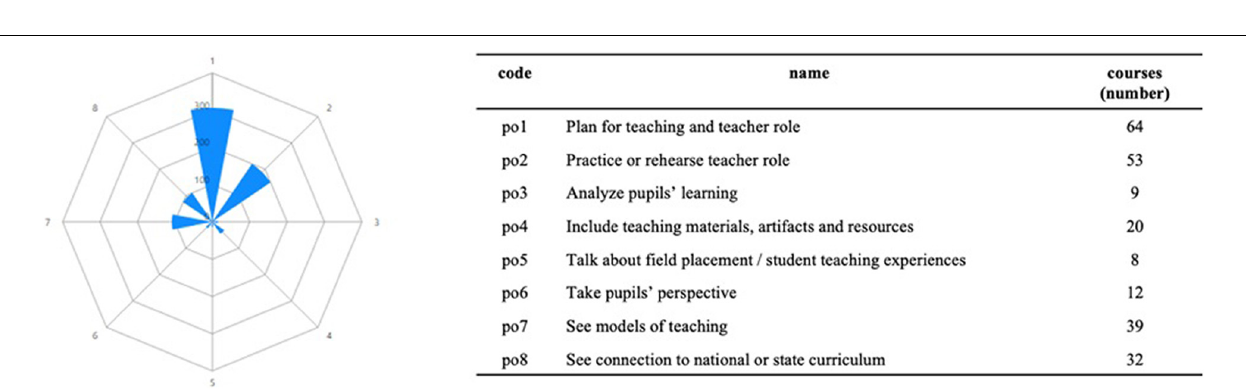
Frontiers in Education |